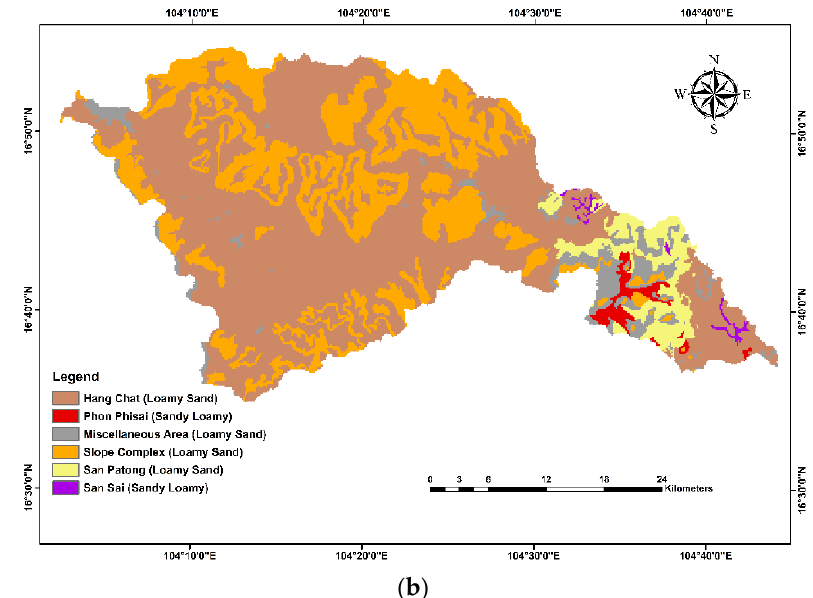
Figure 2. ( a ) Land-use map and ( b ) soil distribution map for the HBS watershed.